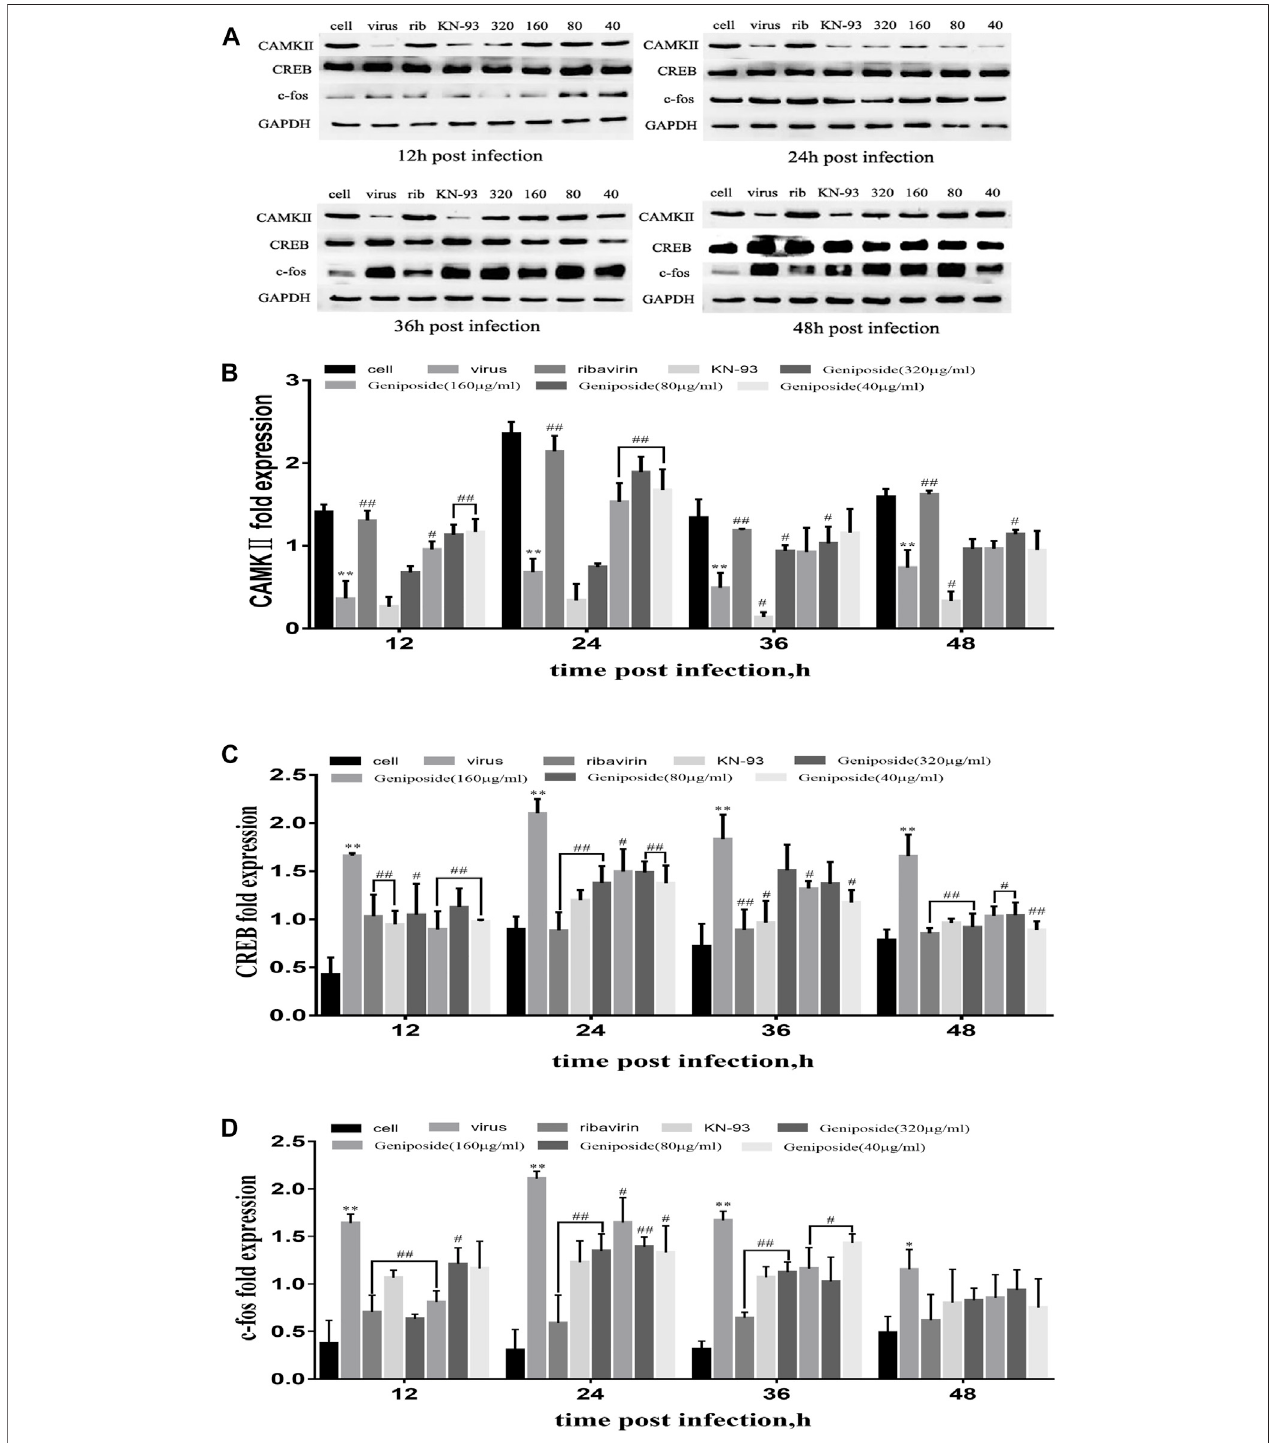
FIGURE6| EffectofgeniposideonCAMKII,CREB,andc-fosexpressionactivatedbyIAVinA549cells.Valuesareexpressedasthemean ± SEM( n (cid:1) 4),** p < 0.01 and* p < 0.05comparedtothenormalcontrolgroup, ## p < 0.01and # p < 0.05comparedtoviruscontrolgroup. (A) CAMKII,CREB,andc-fosexpressionweredetected by Western blotting in A549 cells at 12, 24, 36, and 48 h post infection. (B – D) The relative fold expression of CAMKII, CREB, and c-fos was calculated by the ratio of CAMKII, CREB, and c-fos to GAPDH.